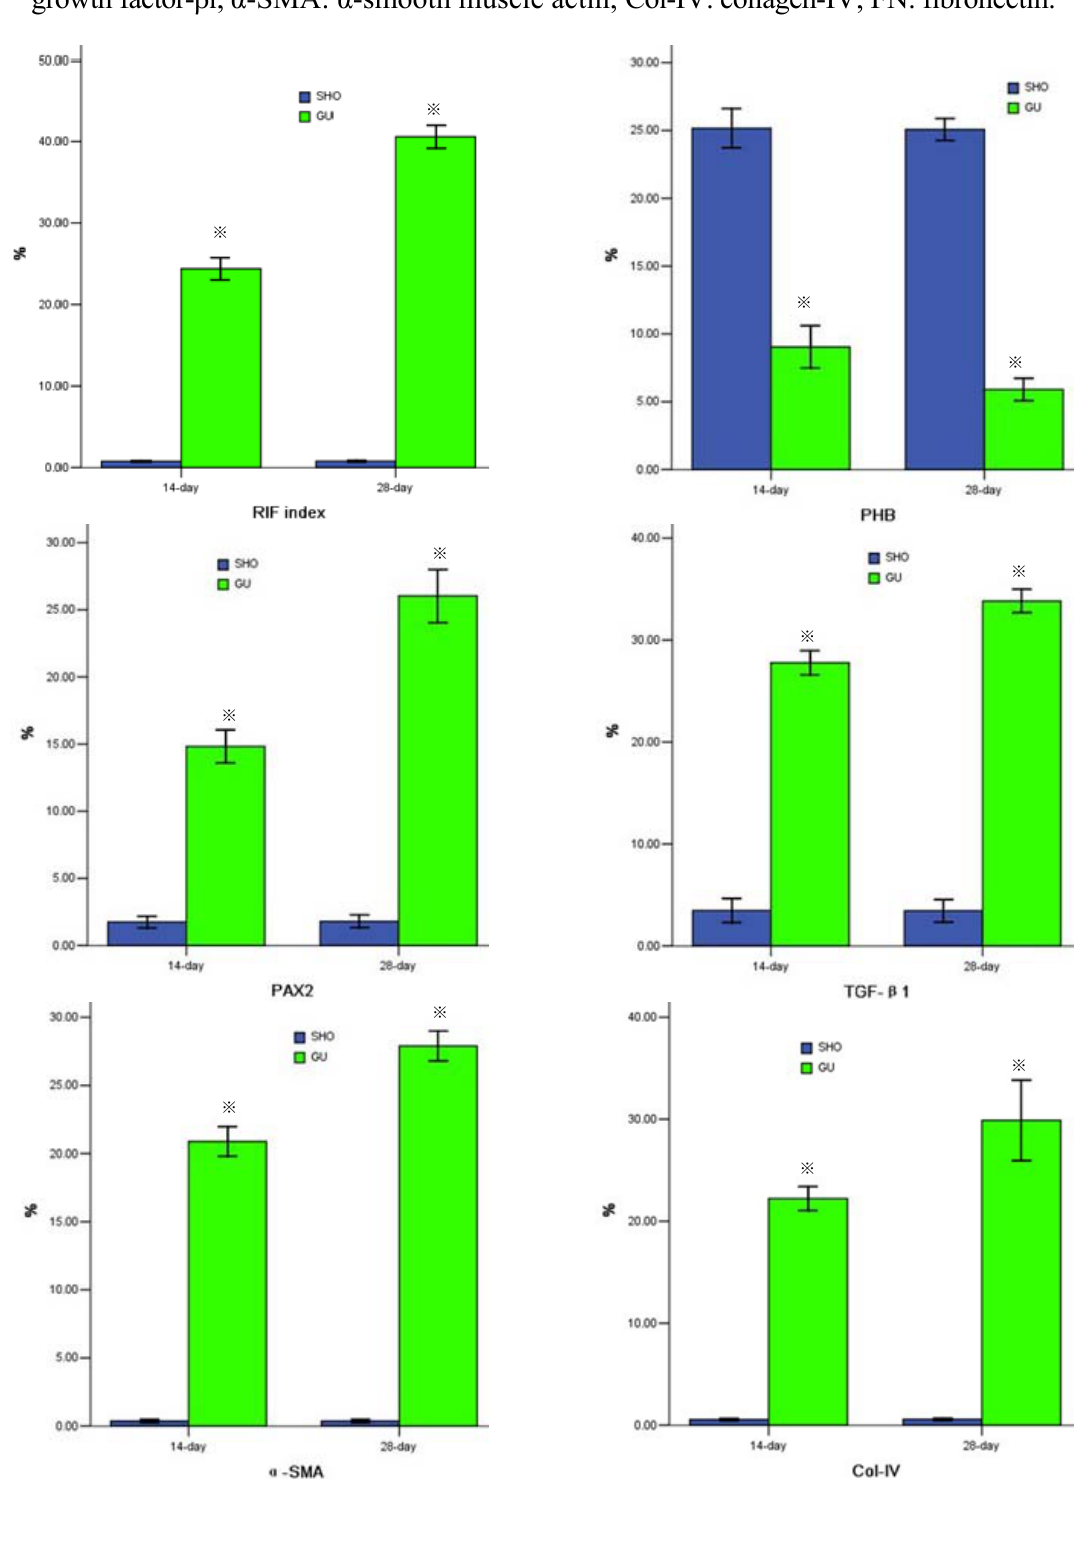
Figure 2. Statistical parameters in two groups. ※ p < 0.01 compared with